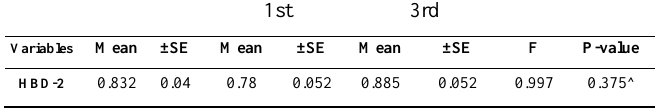
Table 3 : Descriptive and statistical test of hBD-2 among